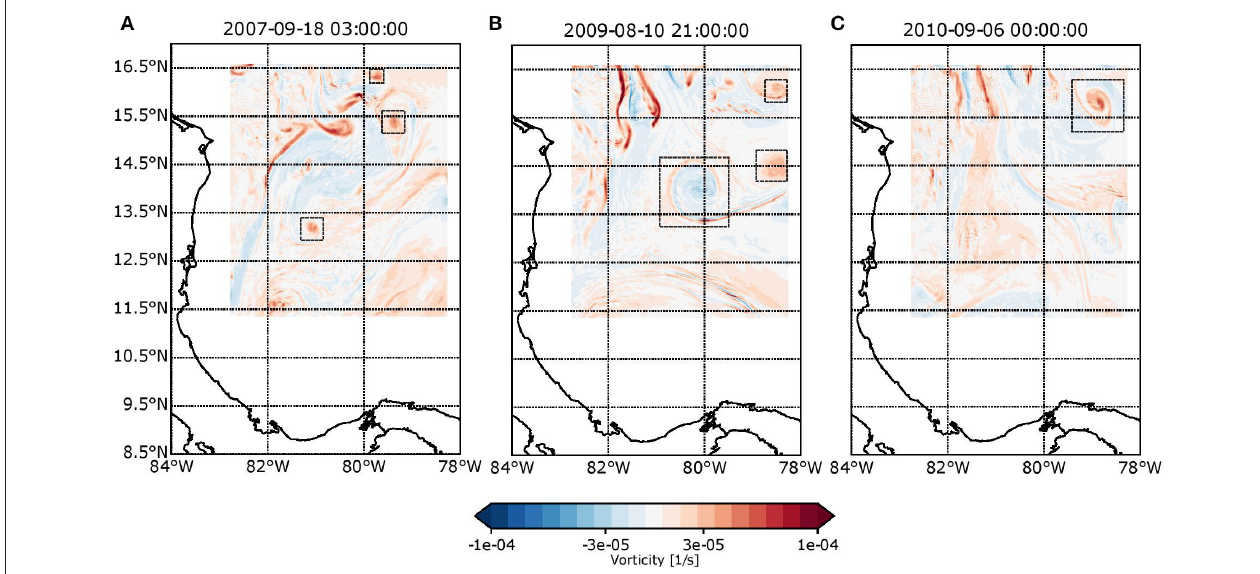
FIGURE 6 | Vorticity fields for (A) 2009-08-10 21:00, (B) 2007-09-18 21:00, and (C) 2010-09-05 21:00. Red coloration indicates anticyclonic spin zones, while blue coloration shows cyclonic spin